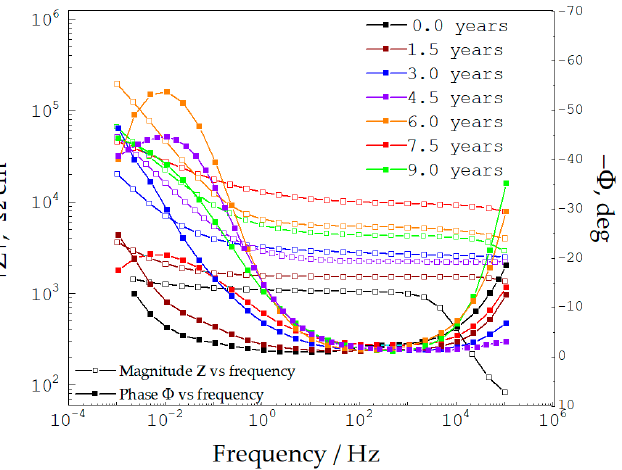
Figure 5. Bode plots for steel samples embedded in concrete and evaluated over a nine-year pe- riod. Table 2. Values of the characteristic parameters used in evaluating the behavior of steel embedded in alkaline-activated concrete, along with its response over time.